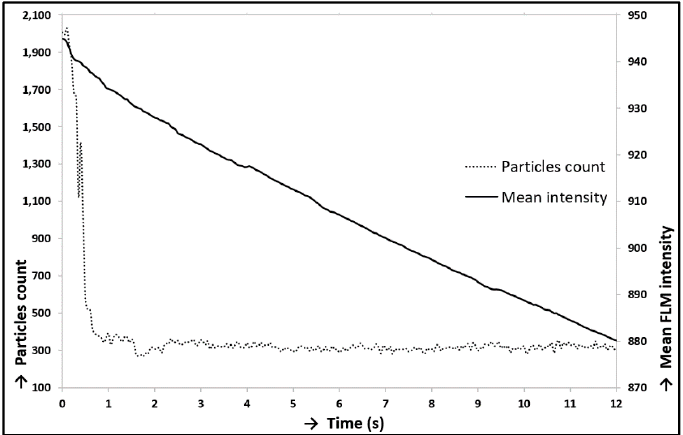
Figure 14. Loading of contact–particles count/FLM (fluorescence microscopy) intensity.